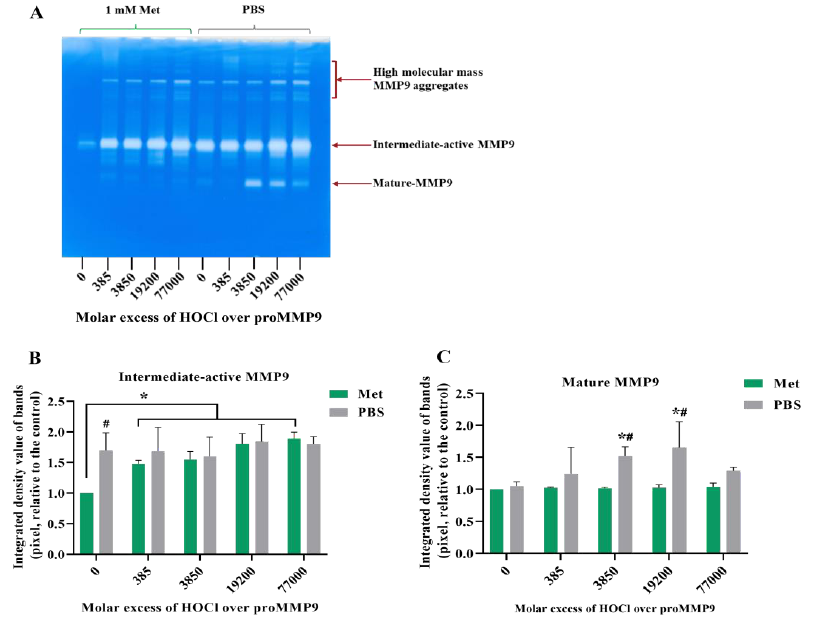
Figure 7. Effect of Met on the activation of proMMP9 by HOCl as detected by zymography. ( A ) proMMP9 (52 nM, 4 μg mL −1 ) was mixed with 1 mM Met or PBS (control) before the addition of the indicated molar excesses of reagent HOCl over protein and subsequent incubation for 24 h at 37 ◦ C, before analysis of the MMP9 activity by gel zymography (see Section 2) with 20 ng proMMP9 loaded per lane and the development of the gel overnight at 21 ◦ C. A representative gel from three independent experiments is presented. ( B , C ) Densitometric data from the combined dataset for the bands at ~92 kD, assigned to the active intermediate form of MMP9 (Panel B), and the band at ~67 kD assigned to mature MMP9 (Panel C), as determined using ImageJ software. Data are mean values ± SDs from three independent gels. Statistical analysis was performed using two-way ANOVA with Dunnett’s multiple comparisons test and Š í d á k’s multiple comparisons test. Statistical significance compared to the untreated group (0 µ M HOCl) is indicated by *; # indicates statistical differences between the Met- and PBS-containing